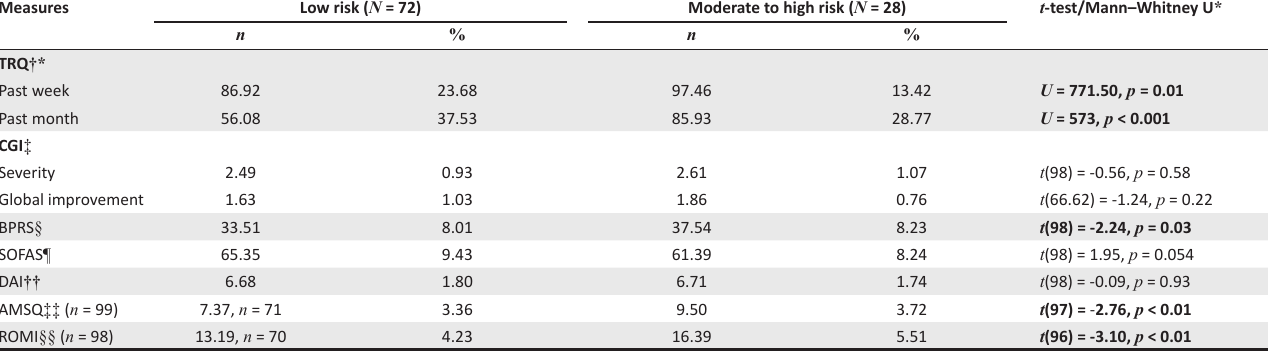
TABLE 3: Questionnaire responses dichotimised by Alcohol Use Disorders Identification Test-defined low risk and moderate to high risk alcohol use groups. Measures